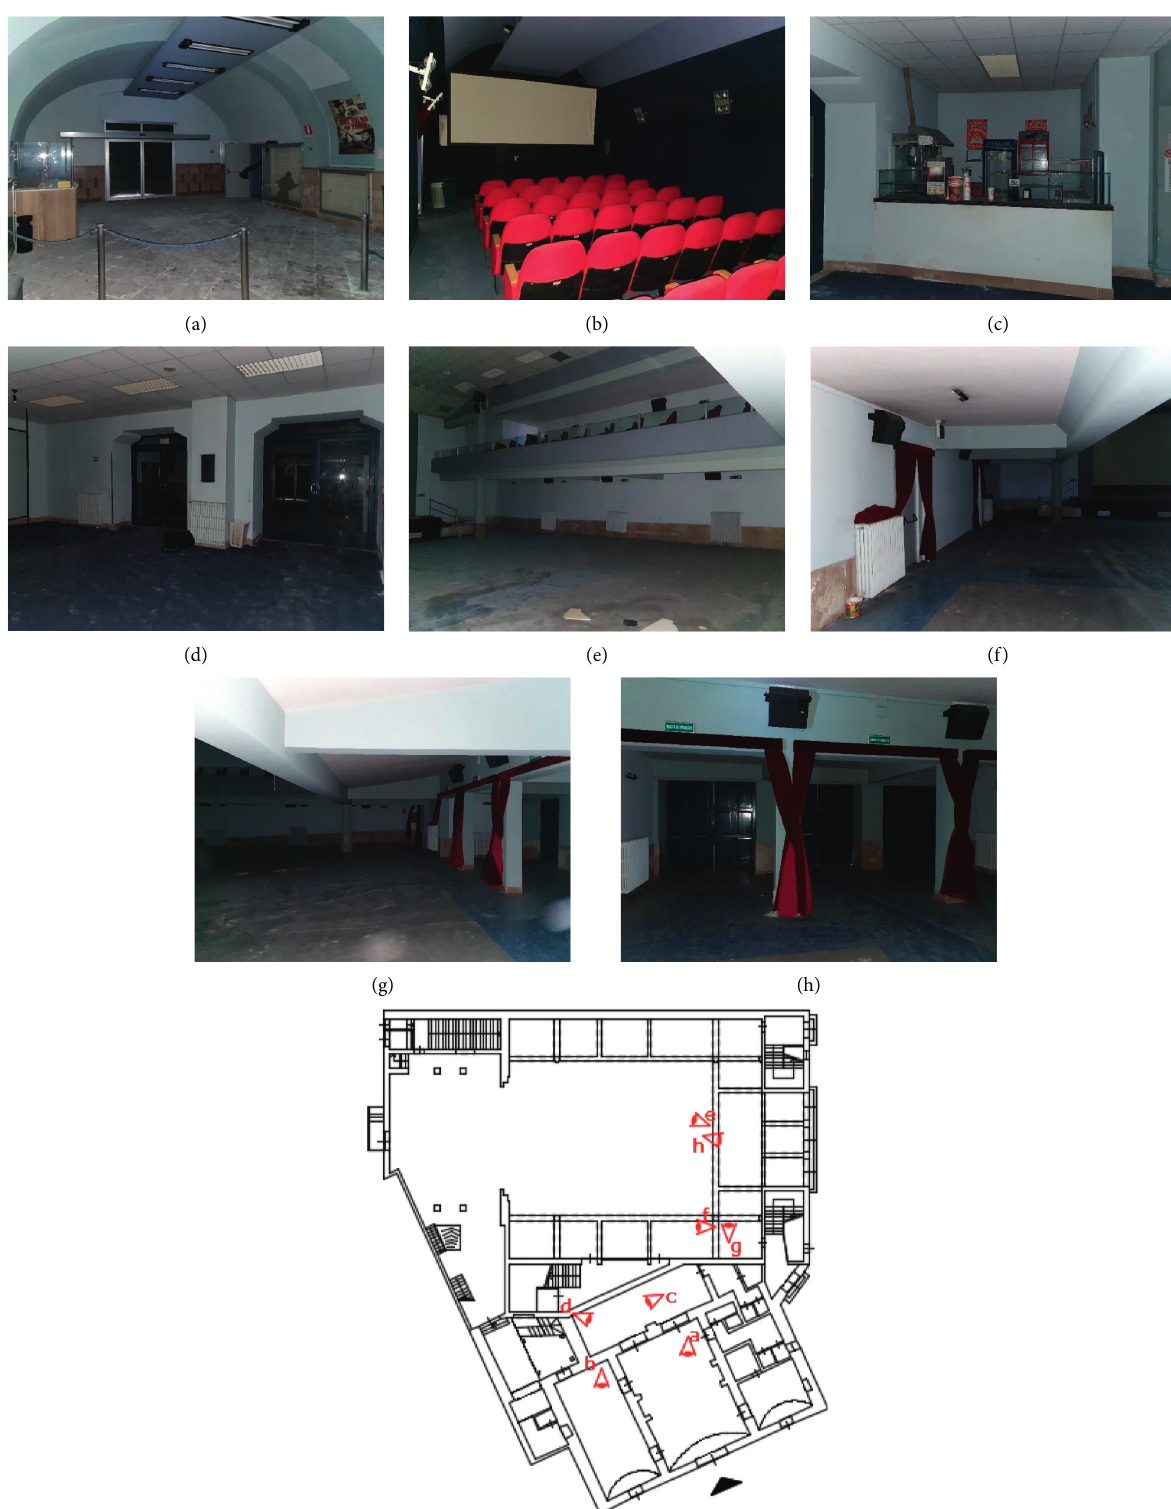
Figure 2: (a-h) inside photos and (i) plan with trigger